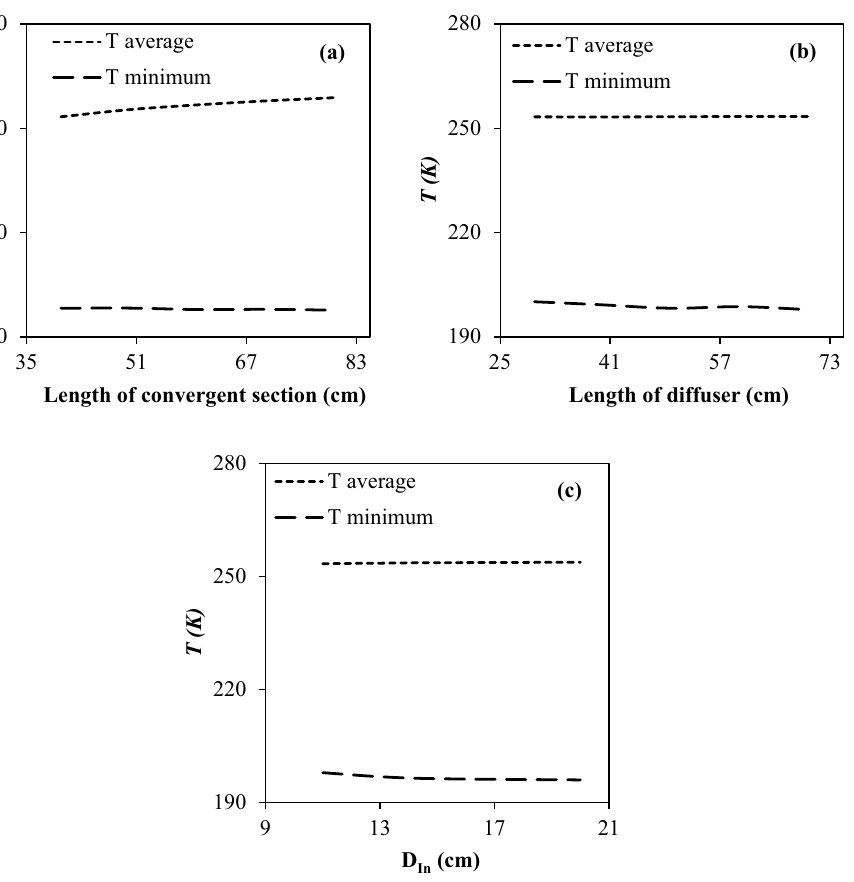
Figure 7. The influence of ( a ) length of convergent section, ( b ) length of diffuser and ( c ) inlet diameter of nozzle on the minimum temperature and average cooling